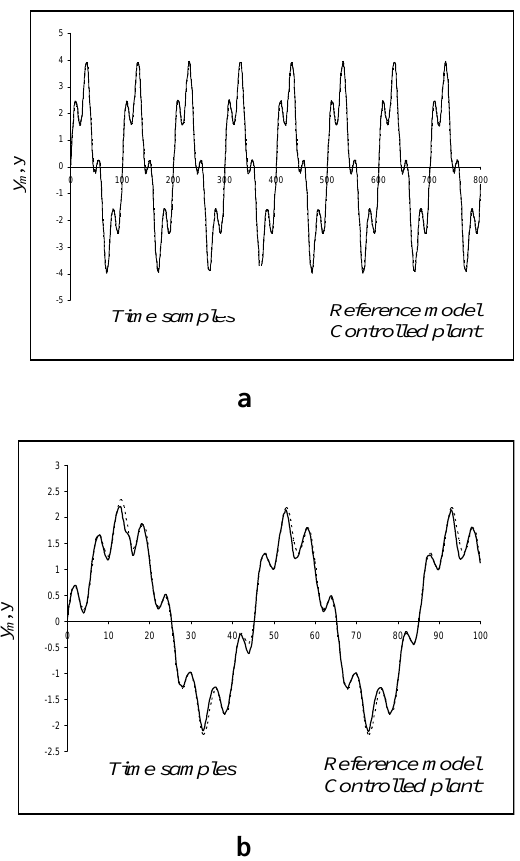
Fig. 8. Outputs of the reference model and the controlled plant resulted from the generalization tests applied on (a) Plant 1 (b) Plant 3 objective functions against